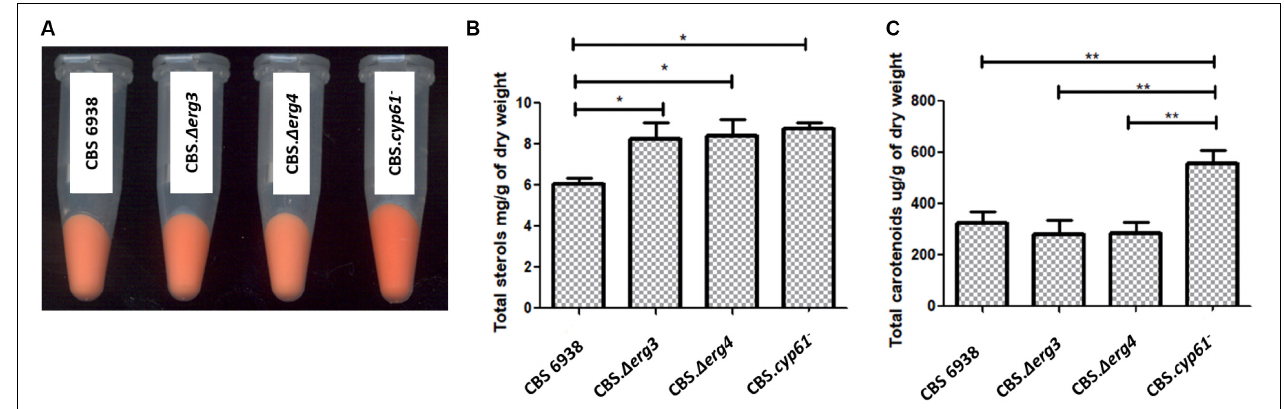
FIGURE 4 | Phenotypic analysis, total sterols and carotenoids between strains CBS 6938, CBS. (cid:49) erg3 , CBS. (cid:49) erg4 and CBS. cyp61 - . (A) Cell pellets of strains CBS 6938 (parental, wild-type strain), CBS. (cid:49) erg3 , CBS. (cid:49) erg4 , and CBS. cyp 61 - obtained from cultures grown on semisolid YM medium incubated at 22 ◦ C for 4 days. (B) Sterols and (C) carotenoids were extracted at the stationary phase of growth cultures (120 h of culture) and quantified at 280 nm and 474 nm, respectively. Values correspond to the average of 3 biological replicas, and the error bars correspond to the standard deviation. Data were normalized with respect to the dry weight of the yeast. * p < 0.05 and ** p < 0.01, Student’s t -test.